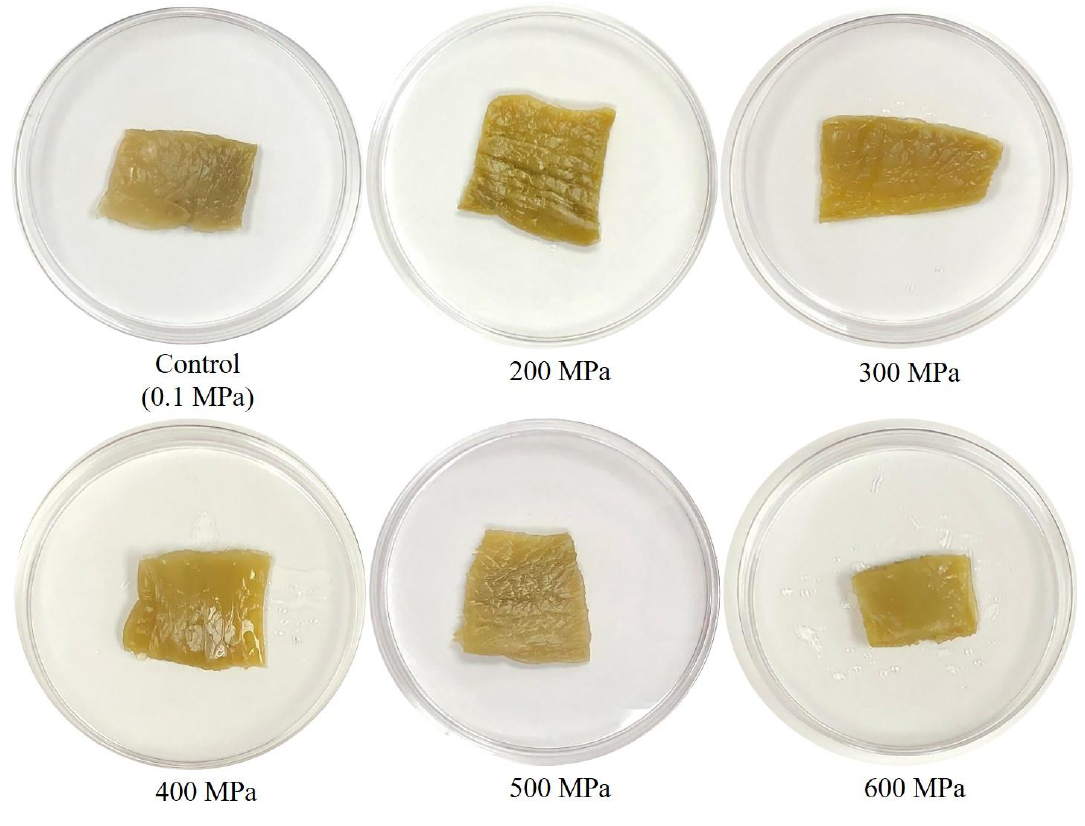
Figure 1. Changes of the appearance in fresh mustard pickles after HHP processing at 200, 300, 400, 500, and 600 MPa for 5 min. Table 2. Values of L* , a* , b* , W , and Δ E in fresh mustard pickles after HHP processing at 200, 300, 400, 500, and 600 MPa for 5 min.